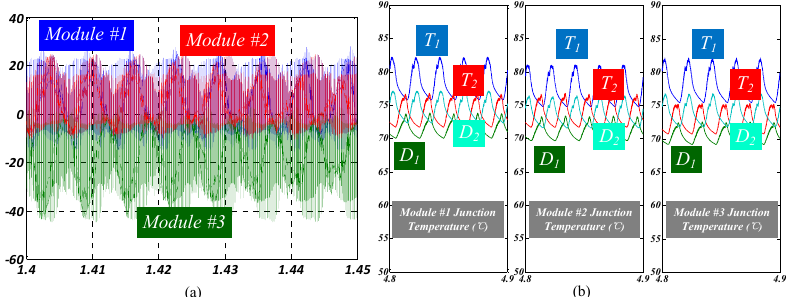
Figure 7. Circulating current and detailed temperature result with obvious circulating current: ( a ) three modules circulating current; and ( b ) detailed temperature in 100% load.